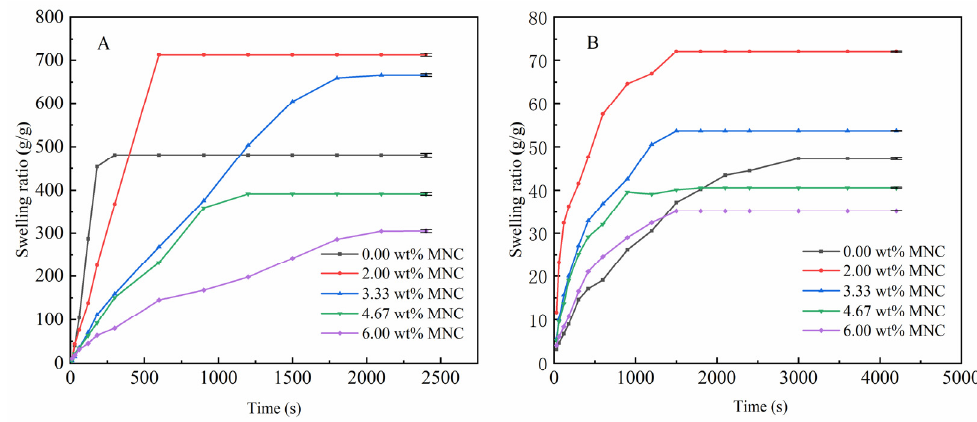
Figure 8. Effect of MNC content on the water absorbency of CAAMC in deionized water ( A ) and 0.9 wt% NaCl solution ( B ).